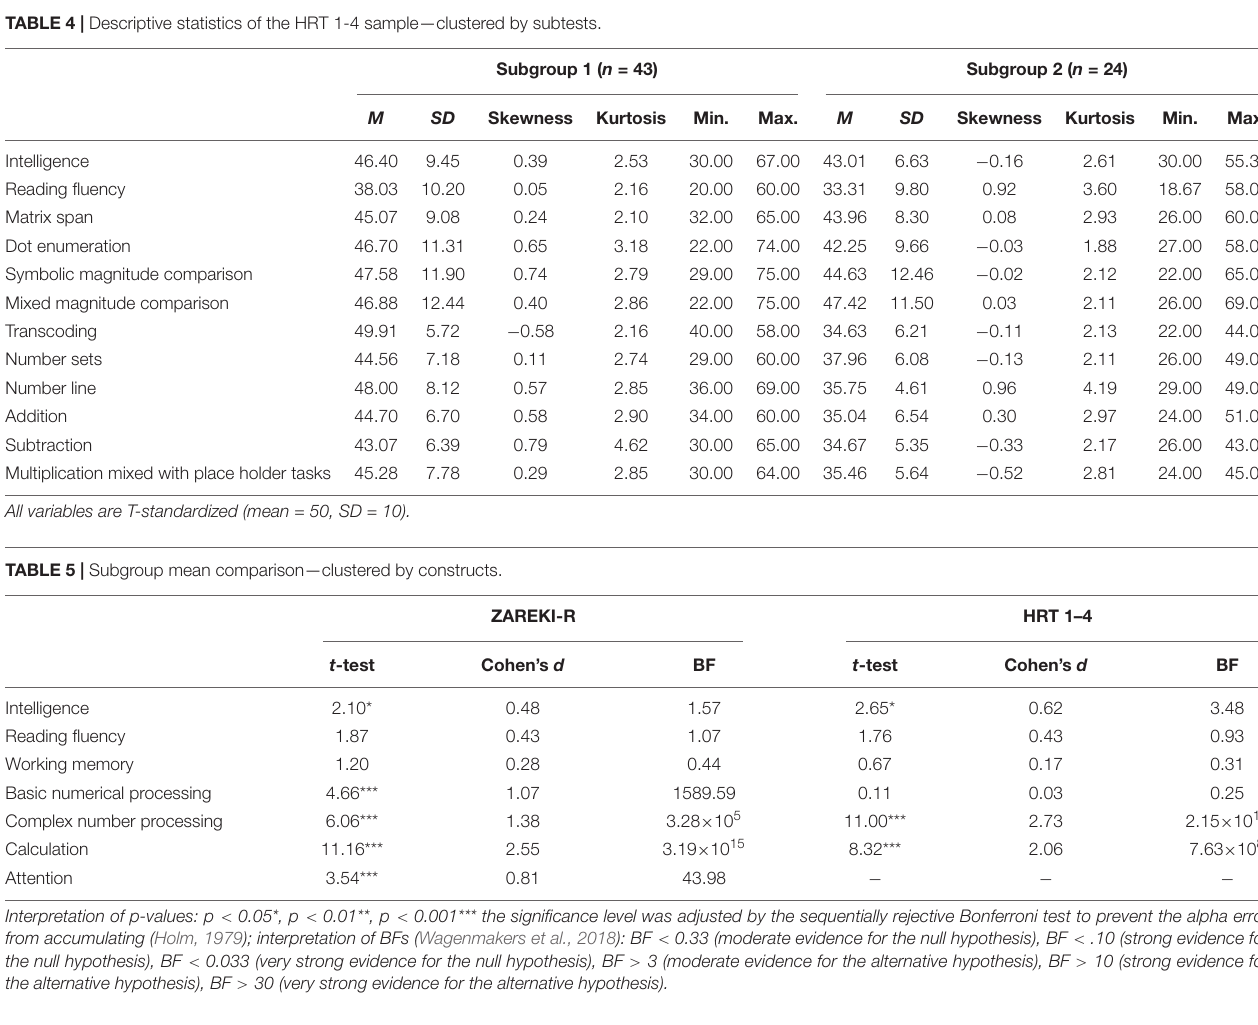
( Table 5 ): t (91) = 2.10, p < 0.05, but BF = 1.57. Differences in intelligence were not significant if the subgroups were clustered at the subtest level ( Table 6 ). Overall, the data suggest a very small difference between subgroups in terms of their language-free intelligence (subgroup 1 > subgroup